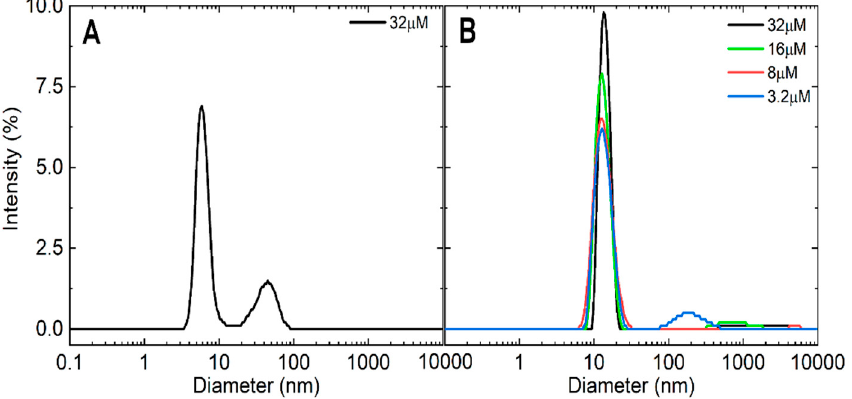
Figure 2. Self-association states of bsHPrK/P monitored by dynamic light-scattering (DLS): The DLS intensity distribution profiles of bsHPrP/K in pure water at 32 µM ( A ) and in 50 mM sodium phosphate buffer (pH 7.0) at different concentrations ( B ). Experiments were carried out at 25 °C.